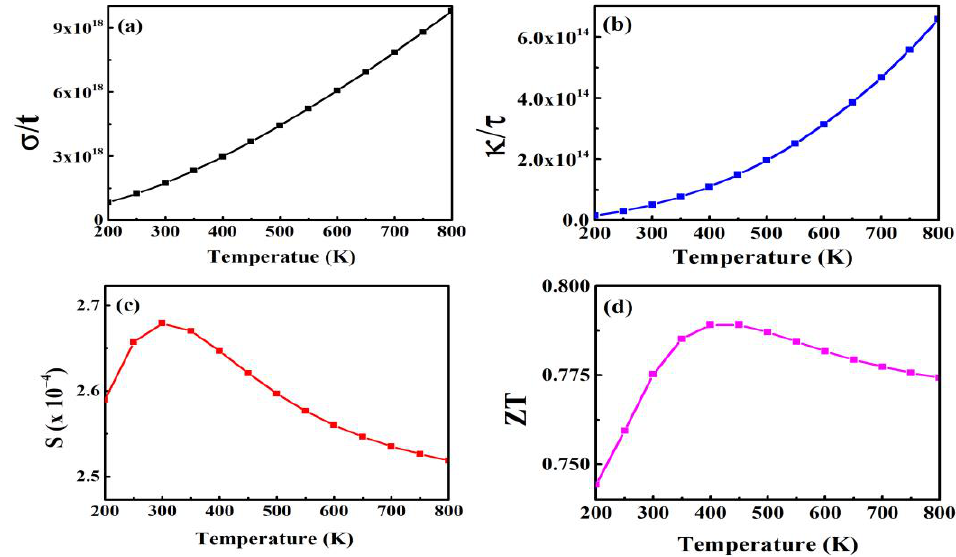
Figure 10. Computed values of ( a ) σ/τ, ( b ) κ/τ, ( c ) S, and ( d ) ZT plotted against temperature (300 – 800) K for ZnS.